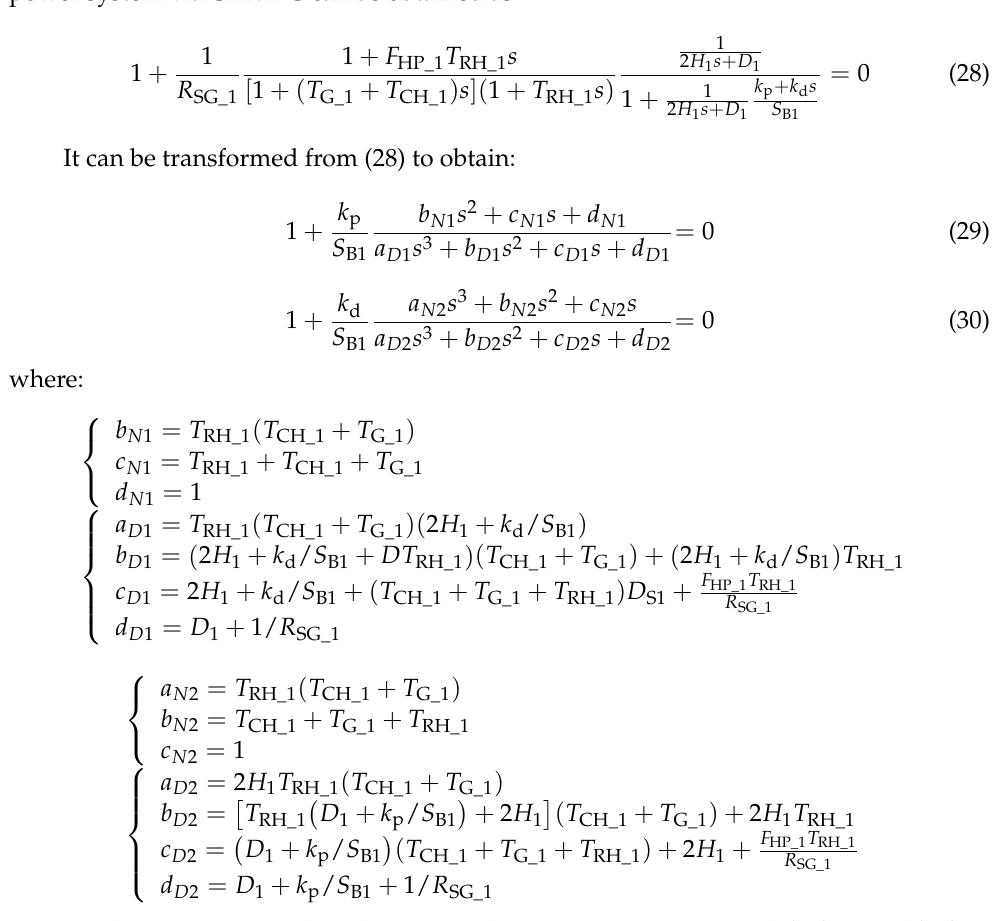
Figure 7. Block diagram of interconnected power system via UHVDC.